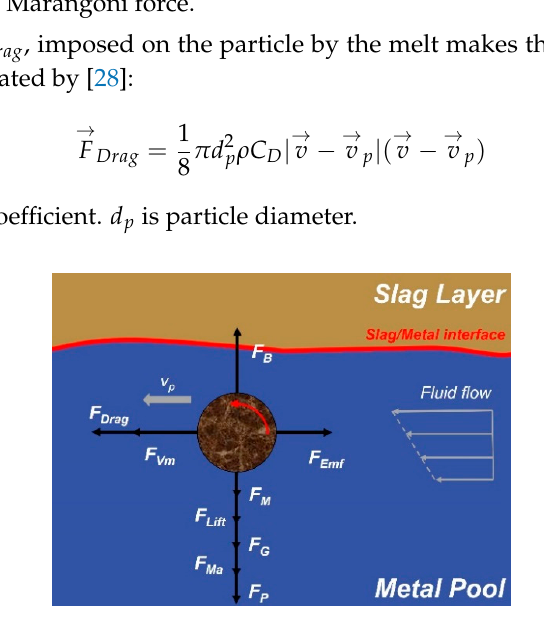
Figure 2. Force balance on a typical particle in the liquid metal pool.